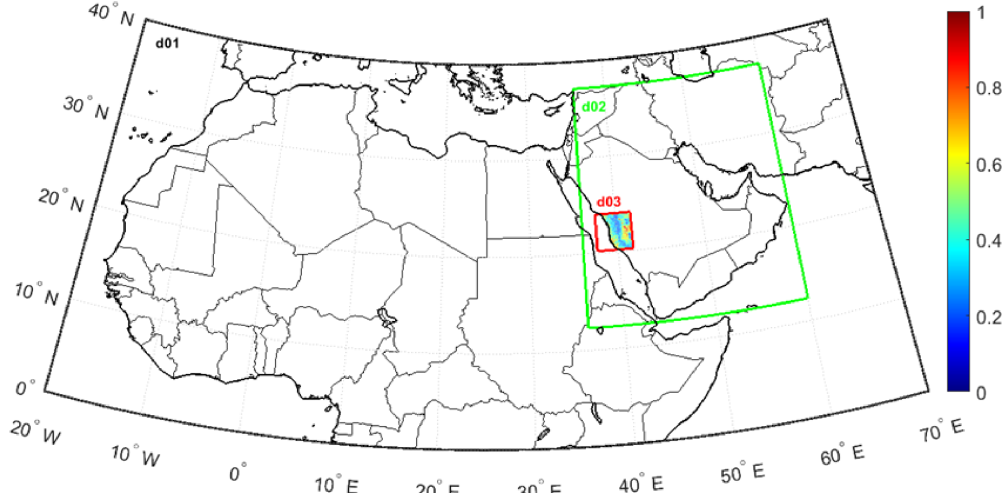
Figure 1. The study region over the Red Sea showing the three nests d01 (black), d02 (green), and d03 (red) used in WRF-Chem simulations. The base map within d03 shows the high-resolution dust source function (Parajuli and Zender, 2017) used in this study, in which the values range from zero to one, with the highest value representing the strongest dust source. Table 1. Details of key physics and chemistry namelist settings used in